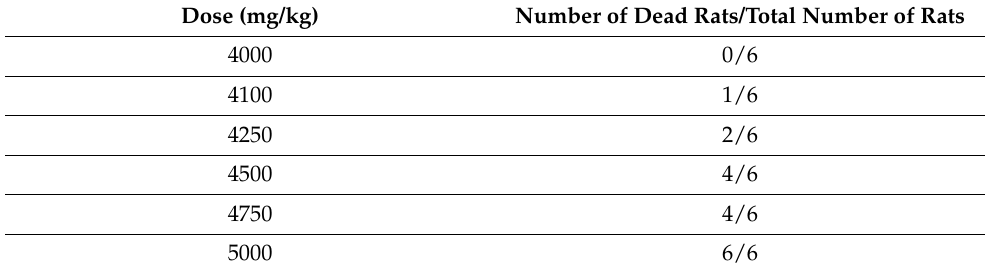
Table 2. Mortality resulting from the intragastric administration